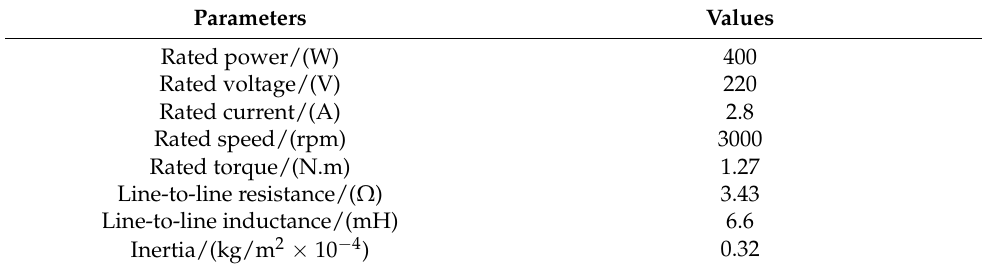
Figure 5. PMSM with the stator inter-turn short fault injection. Table 1. Motor